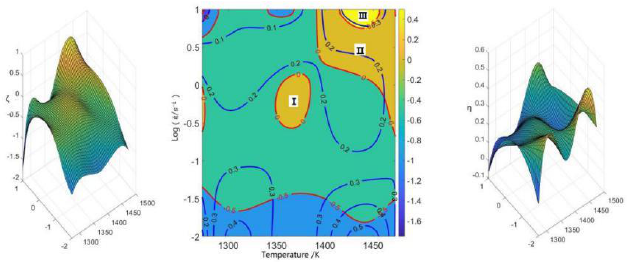
Figure 10. Power dissipation map and instability.